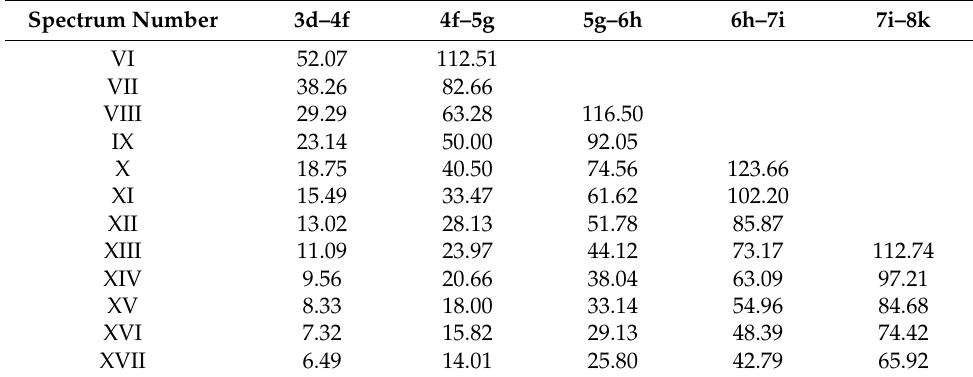
Table 1. EUV wavelengths (in nm) of yrast transitions in hydrogenic approximation. This simple estimate uses the Bohr formula. Because of interactions of the valence electron with the electron core, the real n (cid:96) – n (cid:48) (cid:96) (cid:48) (with n (cid:48) = ( n + 1 ) and (cid:96) (cid:48) = ( (cid:96) + 1 ) ) transition arrays are expected on the short-wavelength side of the